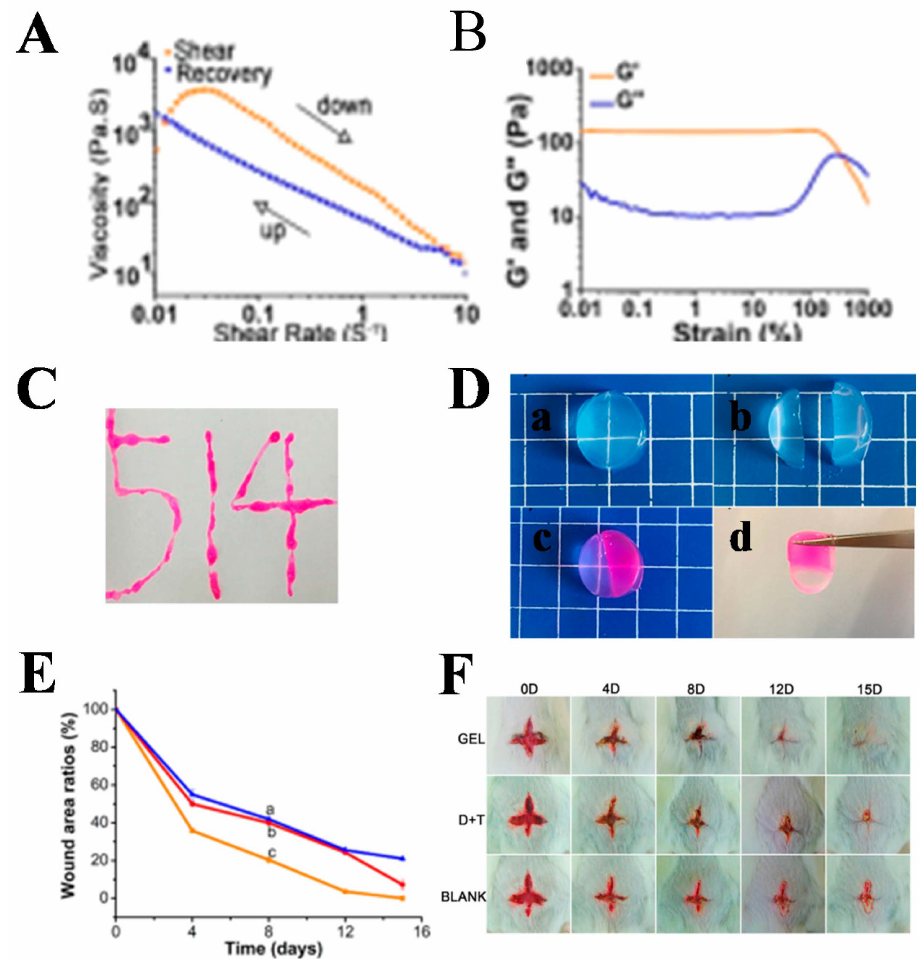
Figure 8. ( A ) Viscosity as a function of shear rate. ( B ) Dynamic modulus of DNT hydrogel under increasing strains from 0.01% to 1000% with a fixed frequency of 1 Hz at 25 ◦ C. ( C ) Injectable property of the hydrogel. ( D ) ( a ) A hydrogel sample was ( b ) cut in half, ( c ) stained with rhodamine (and two fragments were brought together after several minutes), and ( d ) healed into one. ( E ) The wound area was measured by Image Pro Plus and the plot of wound area ratio, from curve a to c, BLANK, (D + T) mixture, DNT hydrogel. ( F ) Photographs of the wounds treated with hydrogels, (D + T) mixture and nontreated at 0, 4, 8, 12, and 15 days, respectively. Reprinted with permission from Ref. [134]. Copyright 2019, American Chemical